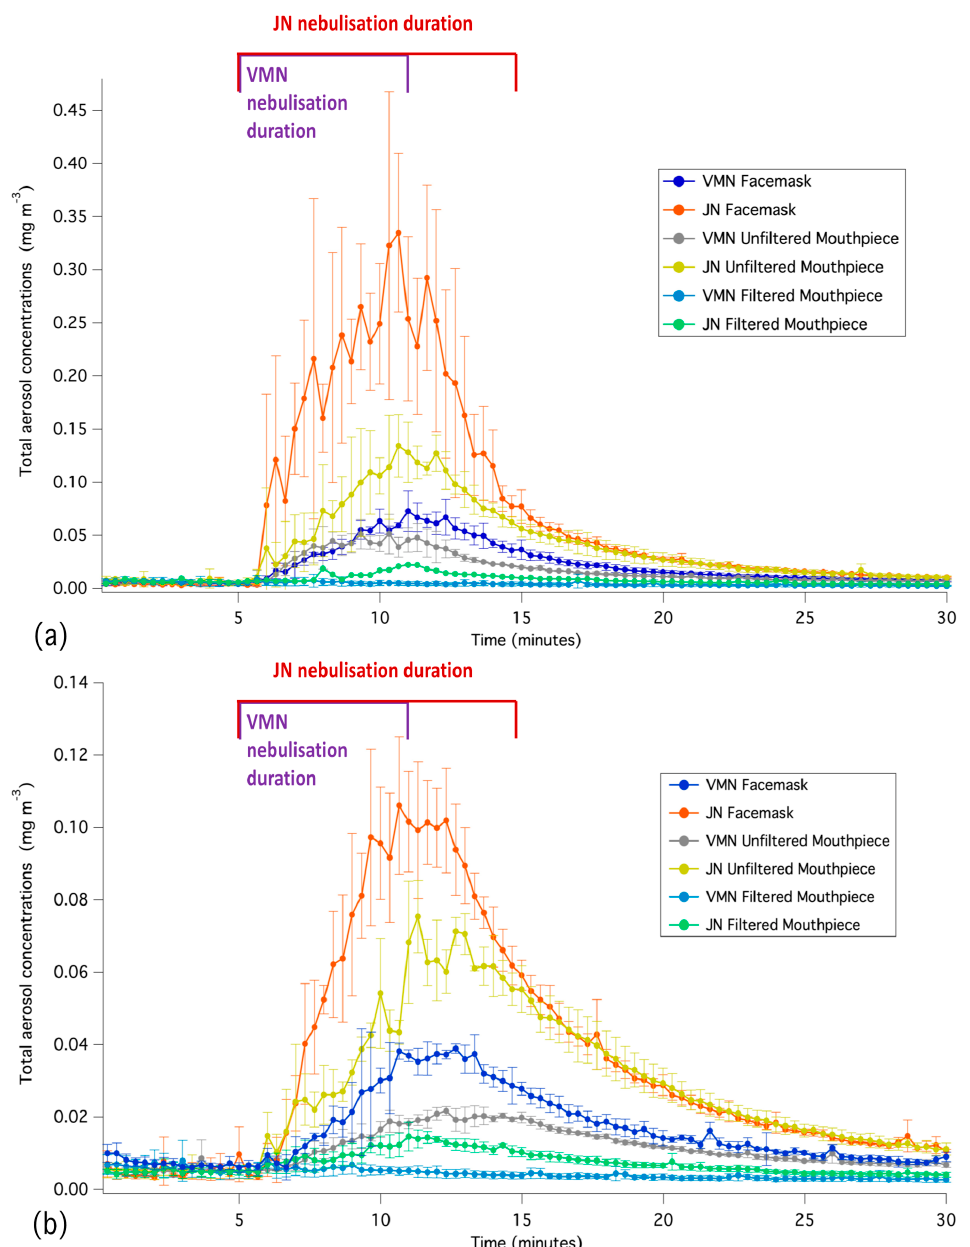
Figure 2. Time-series averaged aerosol concentrations for the three runs recorded at a distance of ( a ) 0.8 m and ( b ) 2.2 m from the different patient interface combinations. The y bars represent one standard deviation at each time step.